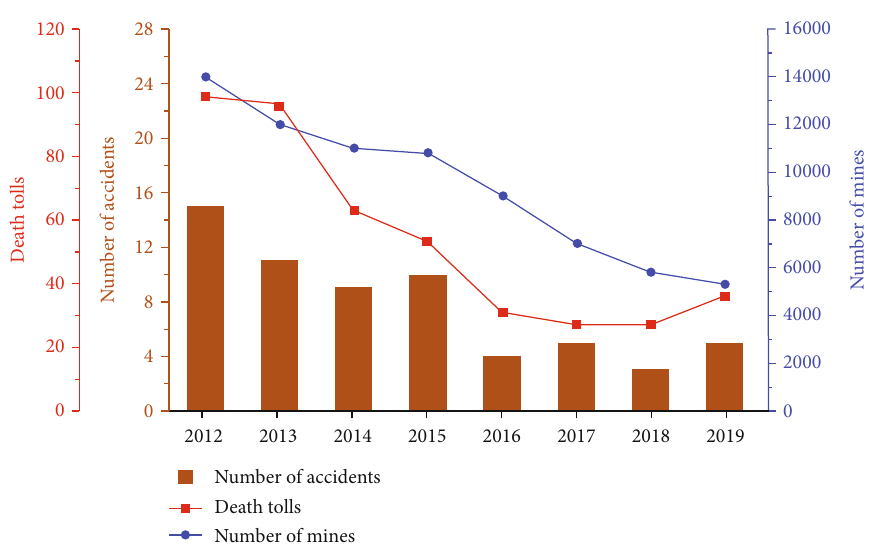
Figure 1: The number of mines, coal and gas outburst accidents, and the death tolls in recent